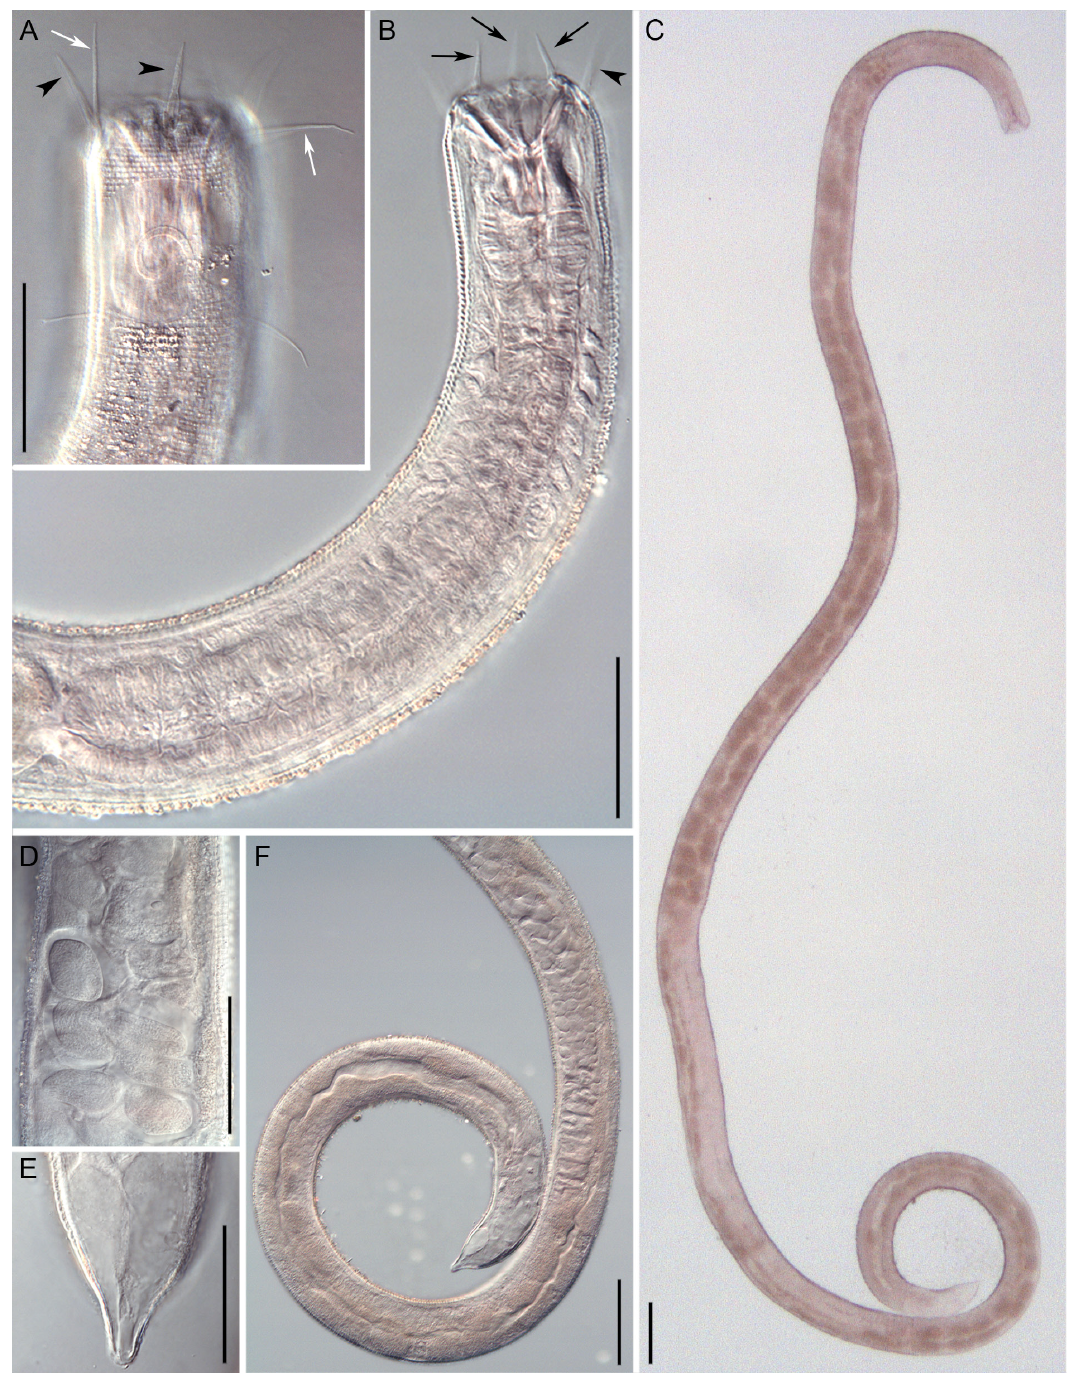
Fig. 3. Gammanema magnum sp. nov., holotype, ♂. A . Surface view of head, showing the large amphideal fovea, outer labial setae (arrowheads), the slender cephalic setae (white arrows), and the transverse rows of punctuations. B . Neck region, showing the leaf-like inner labial setae (black arrows), the broad anterior buccal cavity reinforced by cuticularized rhabdia, each with about six pointed denticles at each posterior end, the narrow and cylindrical posterior buccal cavity surrounded by six broad rhabdia. C . Overview, showing the slender body and conical tail. D . Globular to oval sperm cells. E . Two unequally long spicules. F . Posterior region, showing the opposed testes with globular to oval sperm, the caudal glands with spinneret, and the conical tail. Scale bars: A–B = 50 μm, C–F =